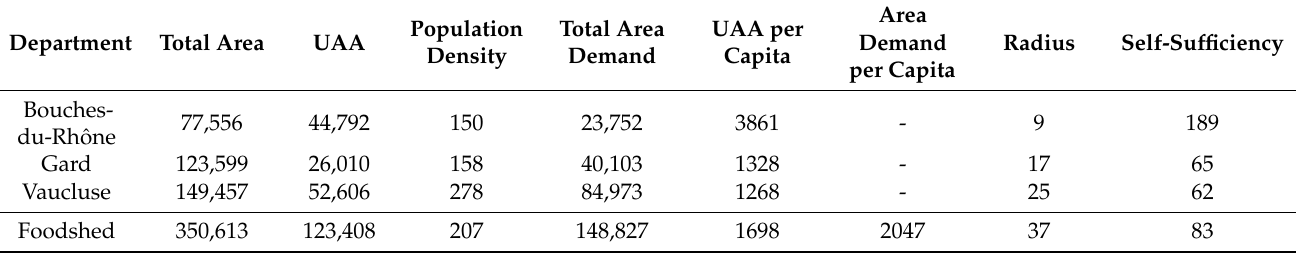
Table 1. Results of the area demand, radius and self-sufficiency for the three departments and the whole